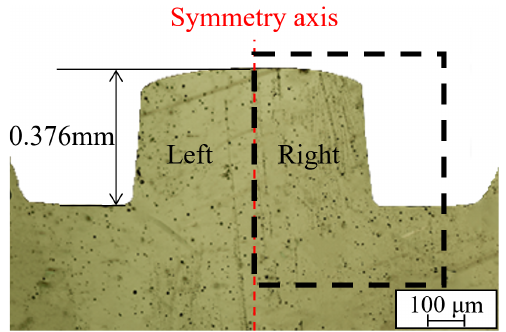
Figure 14. A cross ‐ section view of a filling microfeature.